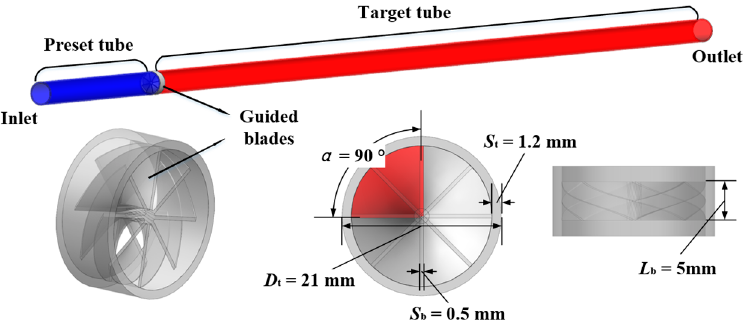
Figure 2. Schematic of the receiver tube with guide vanes.